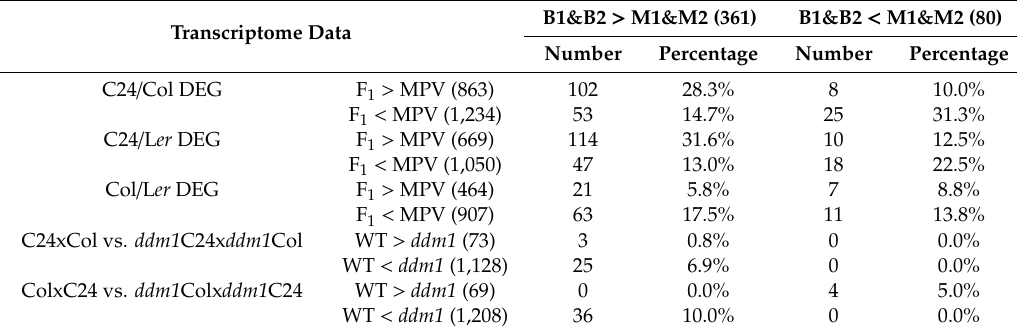
Table 1. Number of genes overlapping with previous transcriptome data.